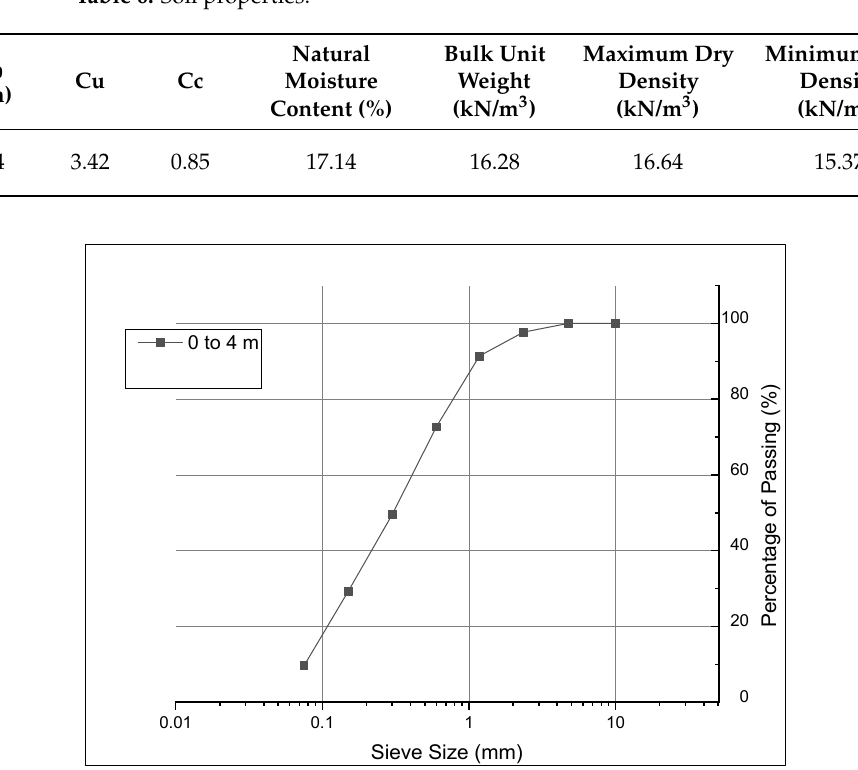
( d ) Figure 5. Casting of the FRP-wrapped piles: ( a ) placement of the reinforcement and concreting; ( b ) curing with wet gunny bags; ( c ) FRP wrapping; ( d ) coating of the epoxy above the FRP. 2.2.5. Soil Condition Poorly graded sand with a fi neness modulus of 2.50 was fi lled and placed sur- rounding the piles before conducting the experiment. Based on the applicable Indian Standard (IS) Codes, the properties of the soil were determined through a series of in situ and laboratory tests using disturbed and undisturbed samples, and they are listed in Ta-